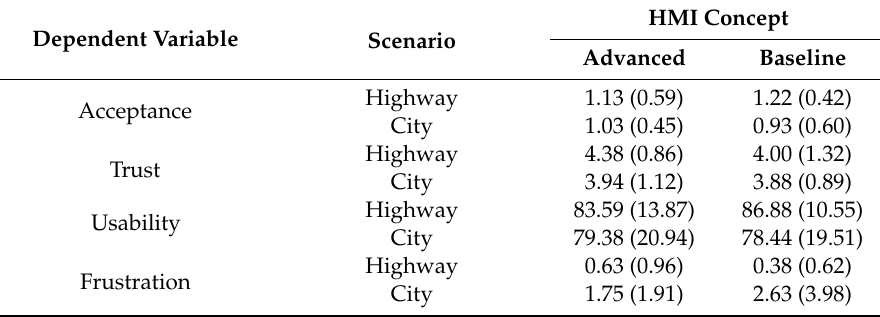
Table 1. Means (and standard deviations) for subjective